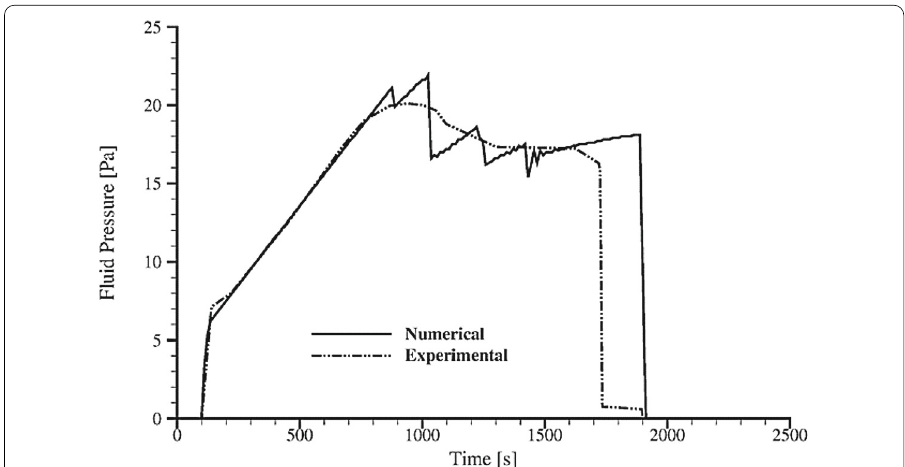
Fig. 3 Laboratory test. Comparison between the time history of the experimental borehole pressure (dashed line) and the numerical prediction (solid line) for the experimentally imposed injection flux